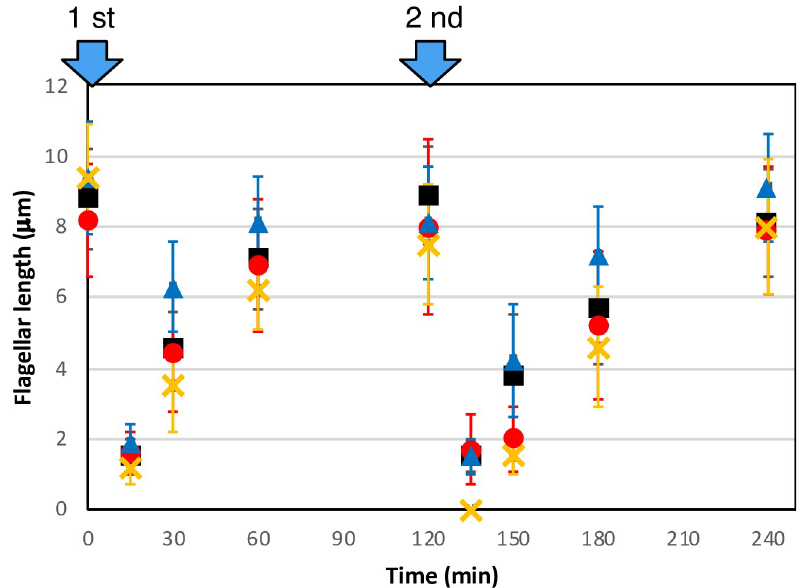
Fig 4. Change in flagellar length after repeated deflagellation in the tubulin-gene disruptants. Horizontal axis indicates time after the 1st deflagellation. Arrows indicate the timing of the 1st and 2nd deflagellation by acid treatment followed by neutralization. Black squares, wild type (CC-125); red circles; tua2-A , blue triangles; tub1-B ; yellow crosses; a tua2-A x tub1-B double mutant. Error bars: SDs (n = 50).